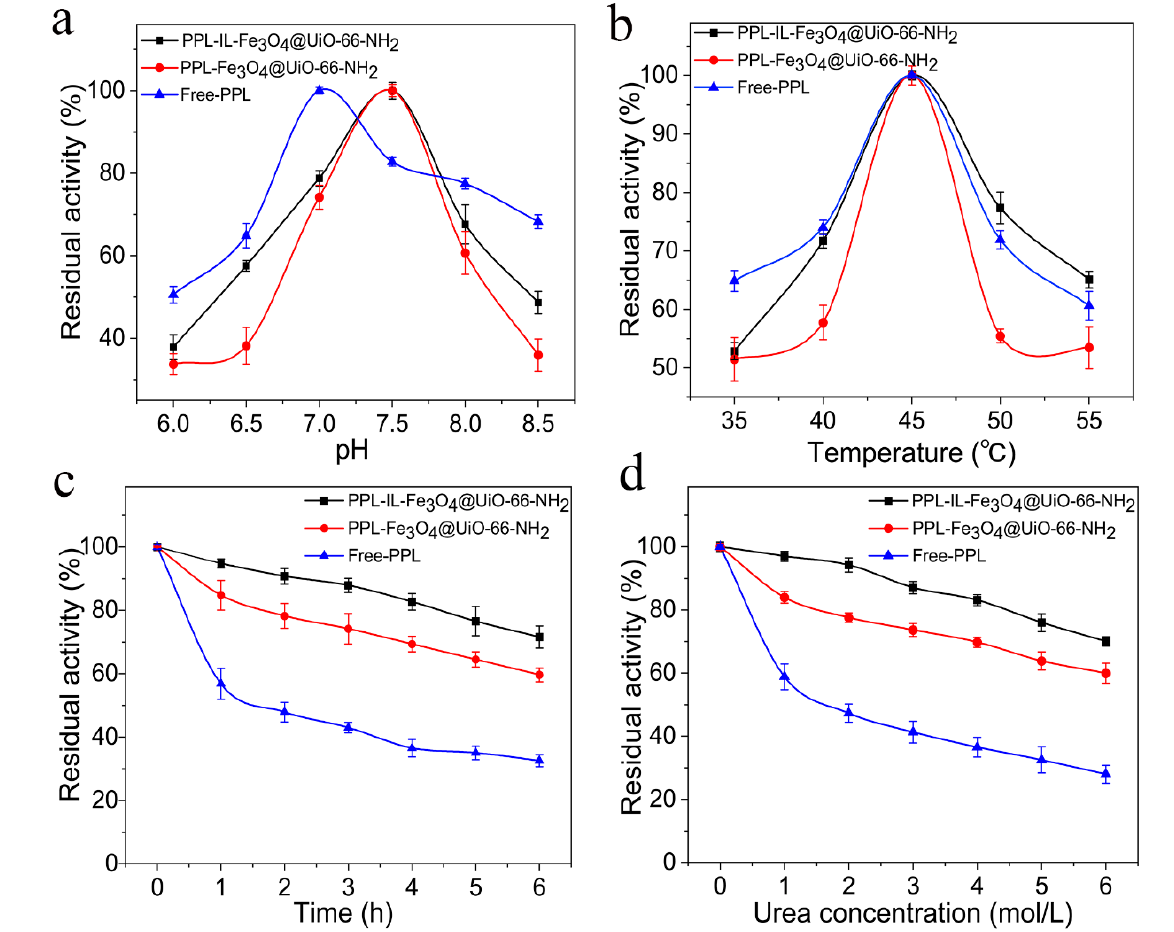
Figure 5. The effects of ( a ) pH and ( b ) temperature on the activity of free or immobilized lipase; ( c ) thermal stability of soluble and immobilized PPL; ( d ) denaturant tolerance of soluble and immobi- lized PPL.